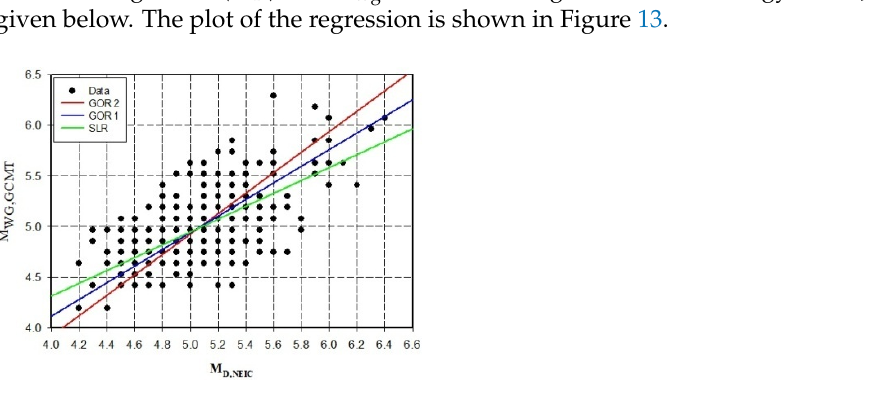
Figure 13. The (M D − M wg ) data, as well as the GOR1, GOR2, and SLR regression lines.